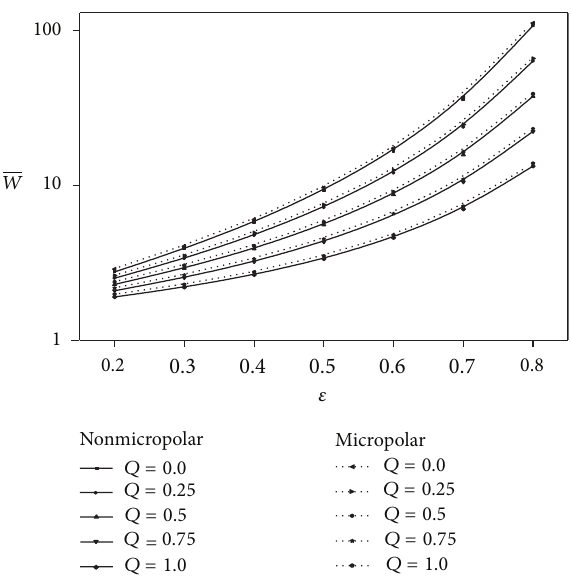
Figure 4: Variation of nondimensional load 𝑊 with 𝜀 for different values of 𝑄 with 𝑙 = 0.4 , 𝑁 = 0.2 , and 𝜆 = 0.5 . values of the coupling number 𝑁 and the microstructure size parameter 𝑙 .